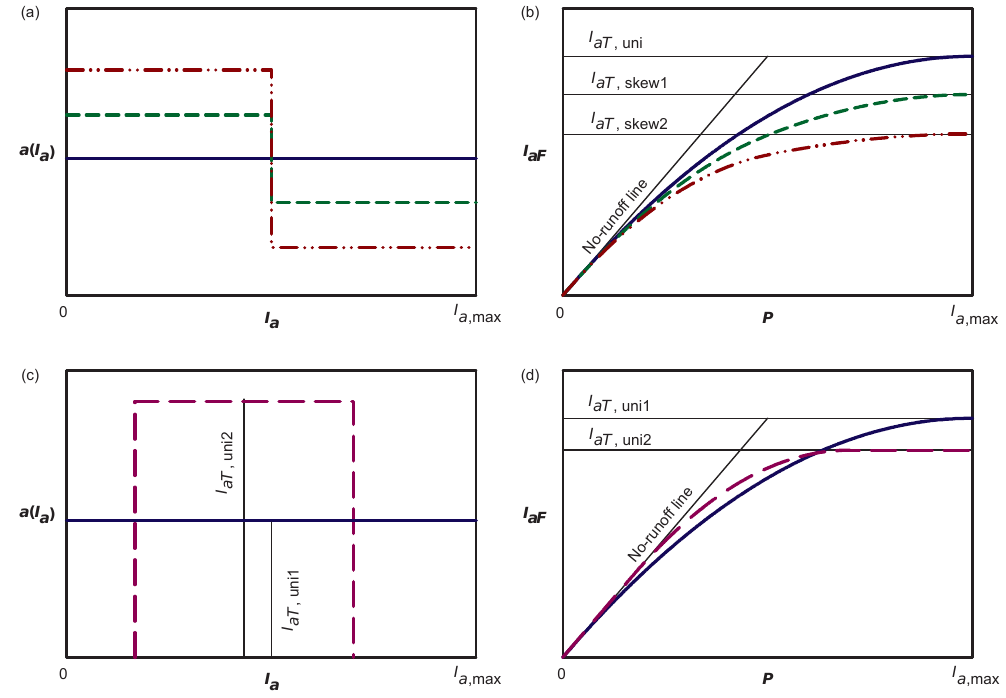
Figure 9. Effect of skewness, mean, and range of a(I a ) on I aF (a) uniform, uni (solid), and two positively skewed distributions, skew1 (dashed) and skew2 (dash, dot, dot); (b) I aF as a function of P for the distributions shown in (a) ; (c) uniform distributions uni1 (solid) and uni2 (dashed) where uni2 has a narrower range of values of I a and a smaller mean than uni1; (d) I aF as a function of P for the distributions shown in (c)